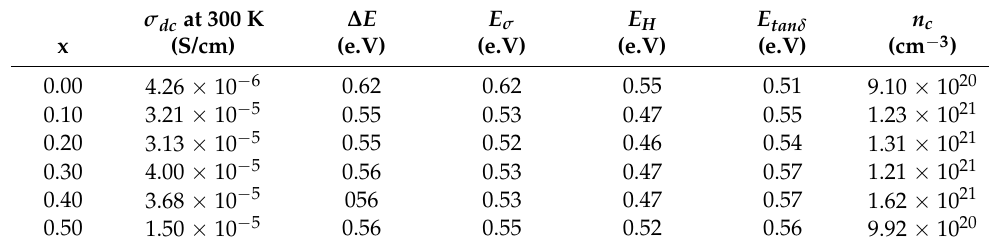
Table 1. The values of σ dc at 300 K and the activation energy ∆ E for ionic conduction